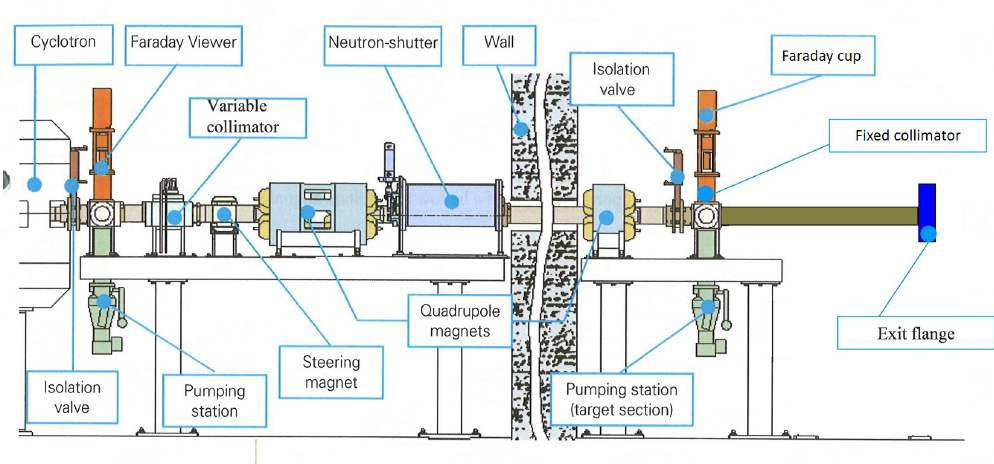
Figure 1. Layout of the external beam